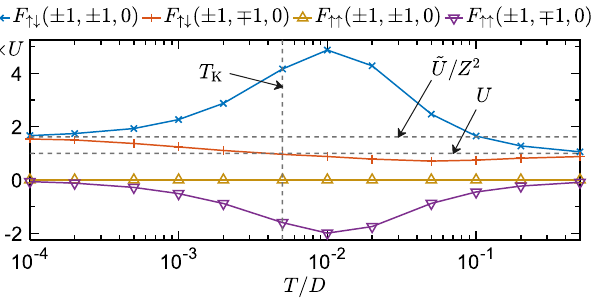
FIG. 10. MF 4p vertex ð F σσ 0 − F 0; σσ 0 Þ =U of the HA (AIM at FIG. 9. The vertex evaluated at the lowest Matsuabra frequen- infinitely strong interaction, Δ =U ¼ 0 ), at ω ¼ 0 . It is calculated cies ν ð0Þ ¼ (cid:4) π T and ω ¼ 0 , denoted by F σσ 0 ð(cid:4) 1 ; (cid:4) 1 ; 0 Þ , as a from the analytic result (85) at a temperature T=U ¼ 1 = 50 ; the function of decreasing temperature. For T ≫ D , the vertex bare vertex F 0; σσ 0 ¼ U δ σ is subtracted for ; ¯ σ 0 reduces to the bare interaction F 0; σσ 0 ¼ U δ σ . Upon lowering ; ¯ σ 0 T , it exhibits strong renormalization effects and undergoes a crossover from increasing to decreasing magnitude for T > T K and T < T , respectively. For T ≪ T , it converges to the K K ˜ U δ ˜ U quasiparticle interaction σσ 0 ¼ σ ; ¯ σ 0 , divided by twice the ˜ U ≃ 0 quasiparticle weight Z . The parameters . 20 U and Z ≃ 0 . 36 were found from RPT and NRG, independent of the 4p computation, and thus provide a strong consistency check.